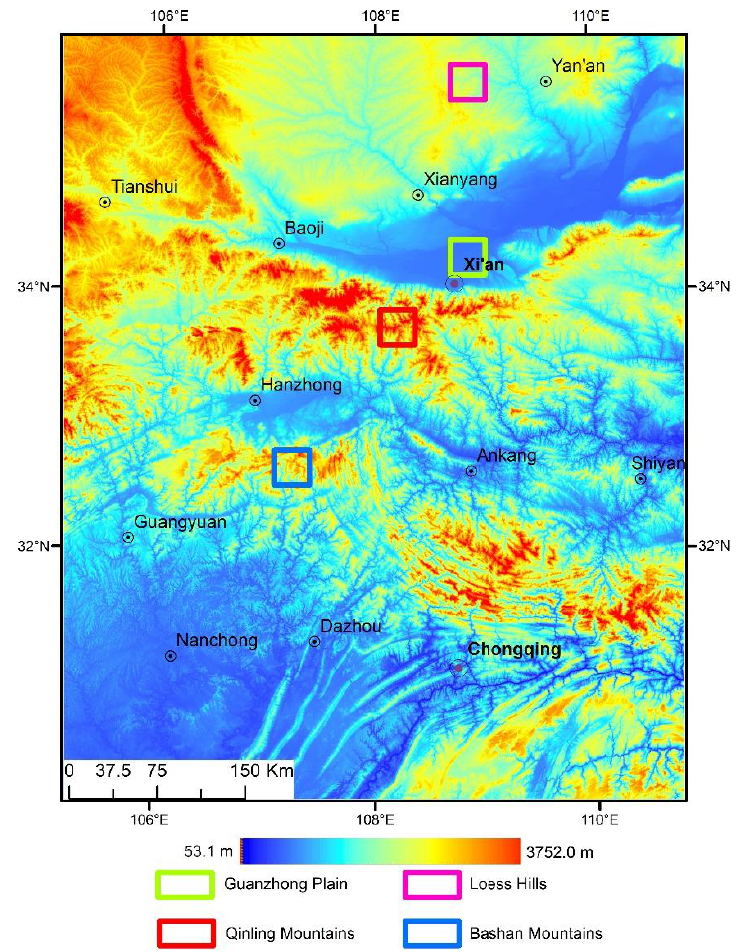
Figure 1. Map of the study area (digital elevation model derived from 1” Shuttle Radar Topographic Mission (SRTM) data).